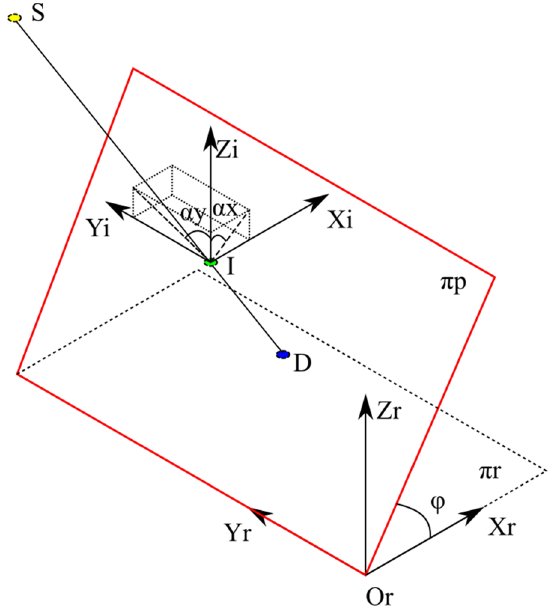
Figure 5. Smart windshield concept.